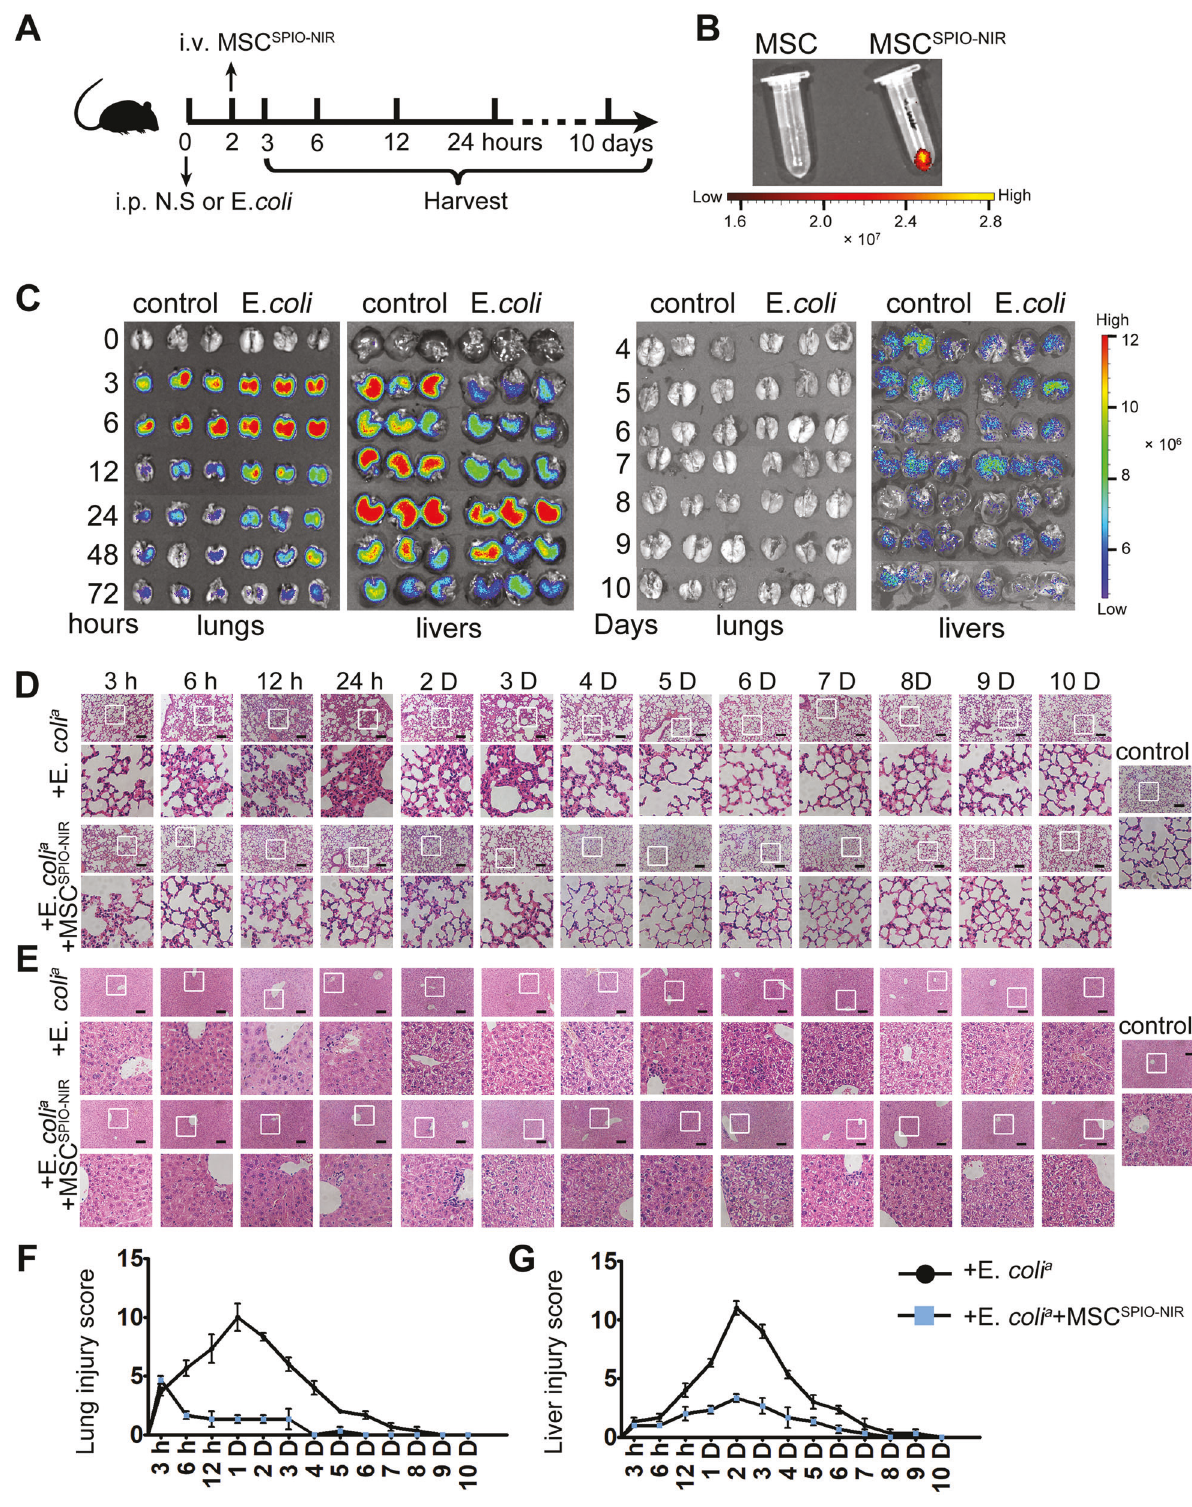
Fig. 2 The spatiotemporal distribution and therapeutic effect of MSC SPIO-NIR . A Schematic of the MSC SPIO-NIR tracing experiment setup ( n = 3). B , C The ex vivo imaging of B EP tubes, C lungs, and livers were carried out on the In Vivo Imaging System. Representative H&E staining of D lung sections or E liver sections. Scale bars, 100 μ m. Histological injury of F lungs and G livers were scored as described in Materials and Methods. Data are shown as mean ± SEM ( n = 3).